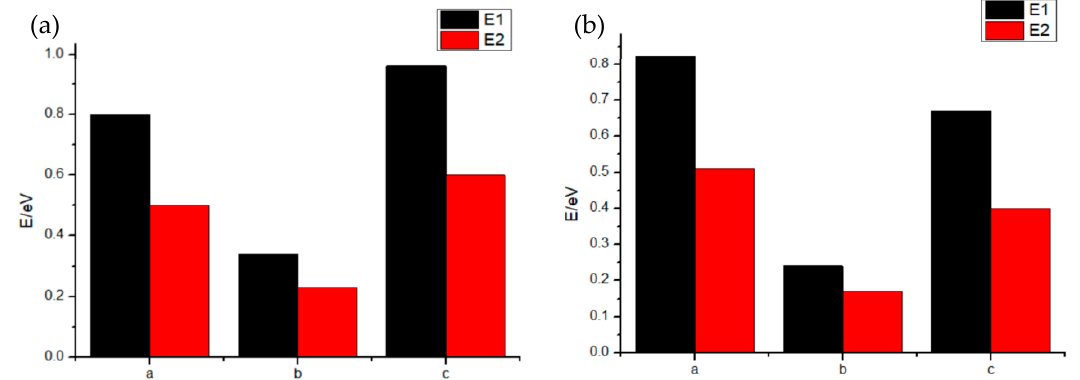
Figure 10. Adsorption energy and di ff usion energy of the Cl − at the passivation film of HEAs: ( a ) the results for the Cr 2 O 3 / TiO 2 interface, ( b ) the results for the Cr 2 O 3 / Nb 2 O 5